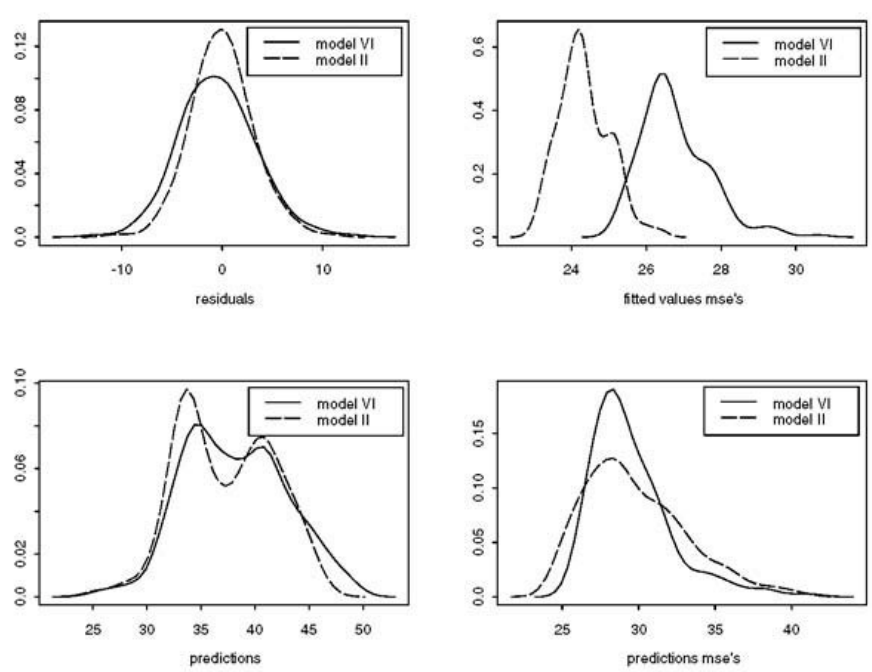
Figure 6 – Marginal density plots (based on a kernel smoothing) of residuals, fitted values mse’s, predictions and predictions mse’s for models VI and II.